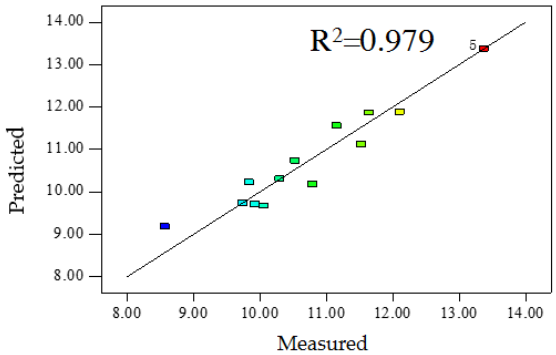
Figure 7. The measured value and the predicted value for the Marshall stability.